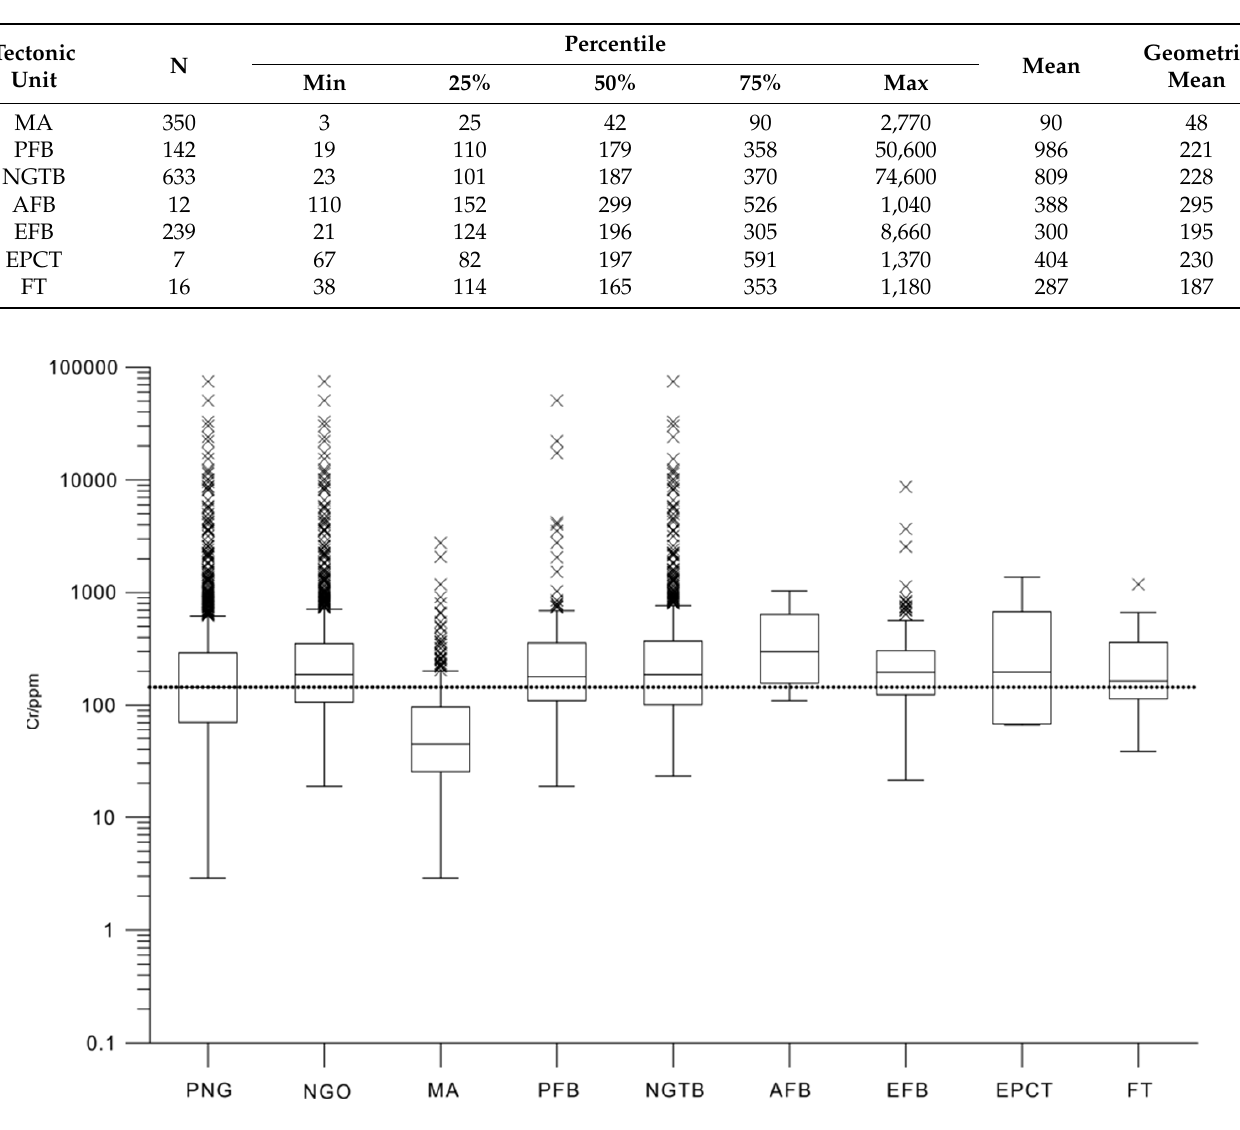
Figure 4. Boxplots showing the variations of chromium values in stream sediments from different tectonic units. Table 4. The statistical parameters of the chromium concentration (ppm) of stream sediments in different tectonic units based on the national ‐ scale geochemical mapping project data. NGO: New Guinea Orogen.